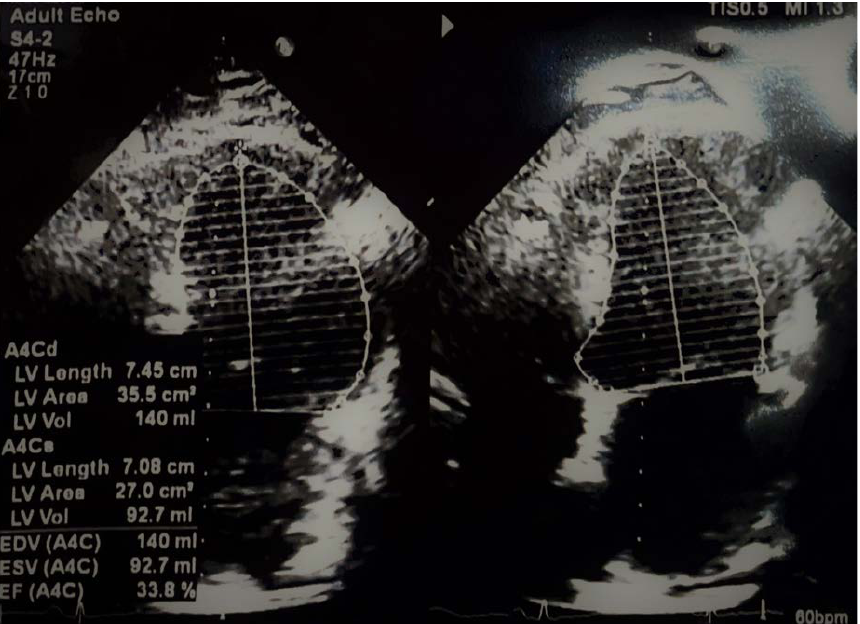
Figure 1. Apical 4-chambers (A4C) echocardiography: moderately decreased left ventricular ejection fraction (LV, left ventricle; EDV, end-diastolic volume; ESV, end-systolic volume; EF, ejection fraction).